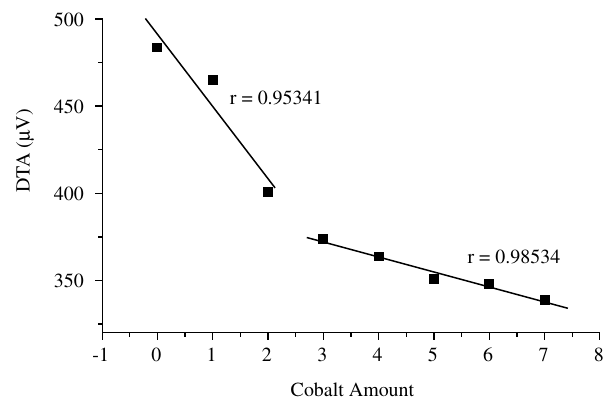
Sb O ; b) Co Zn Sb O , 7 2 12 1 6 2 12